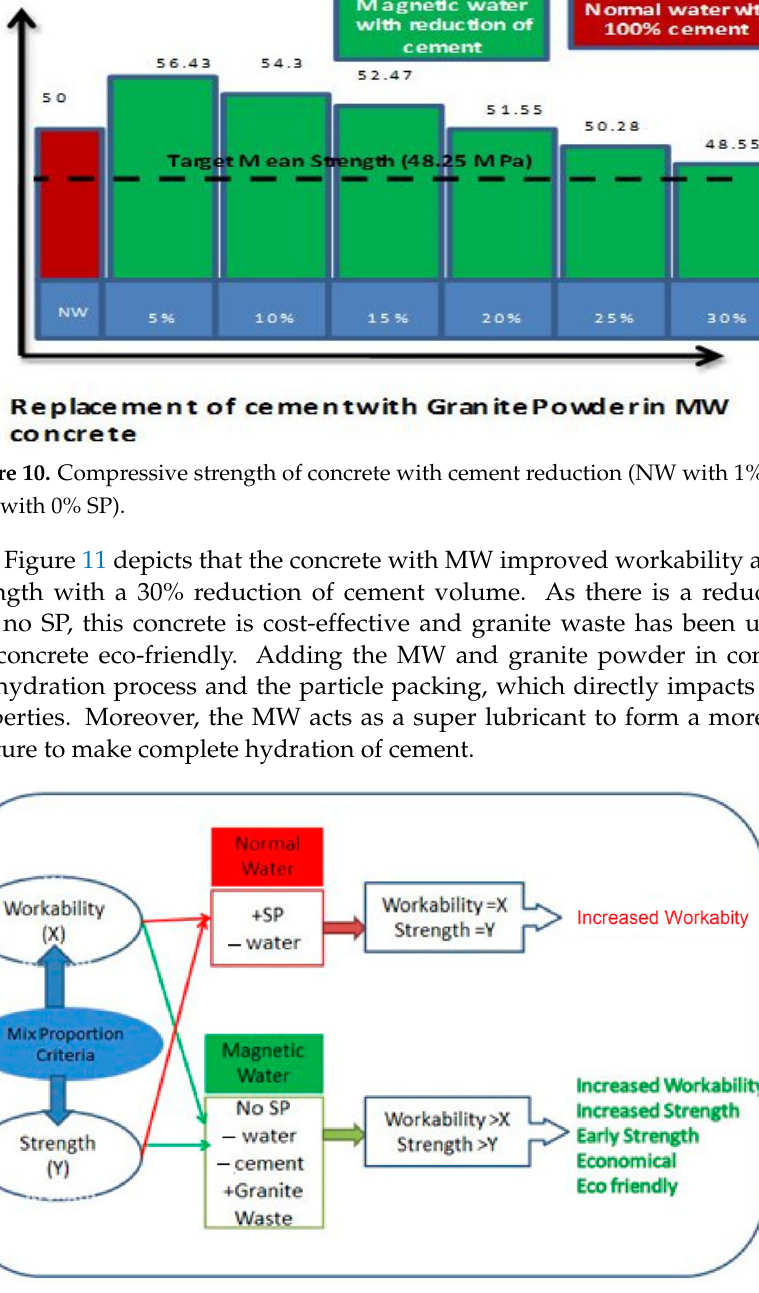
Figure 11. Function of MW in concrete.